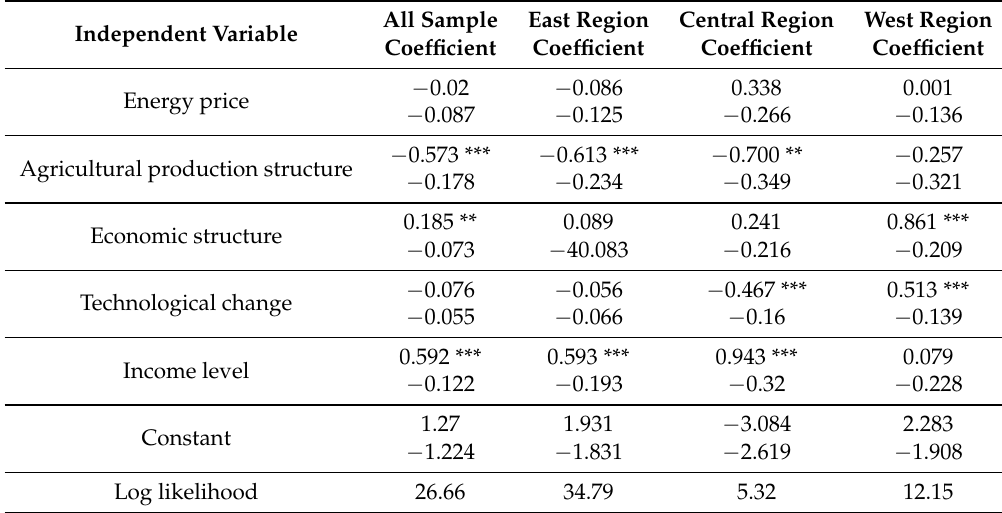
Table 5. Results of Tobit regression (Dependent variable: